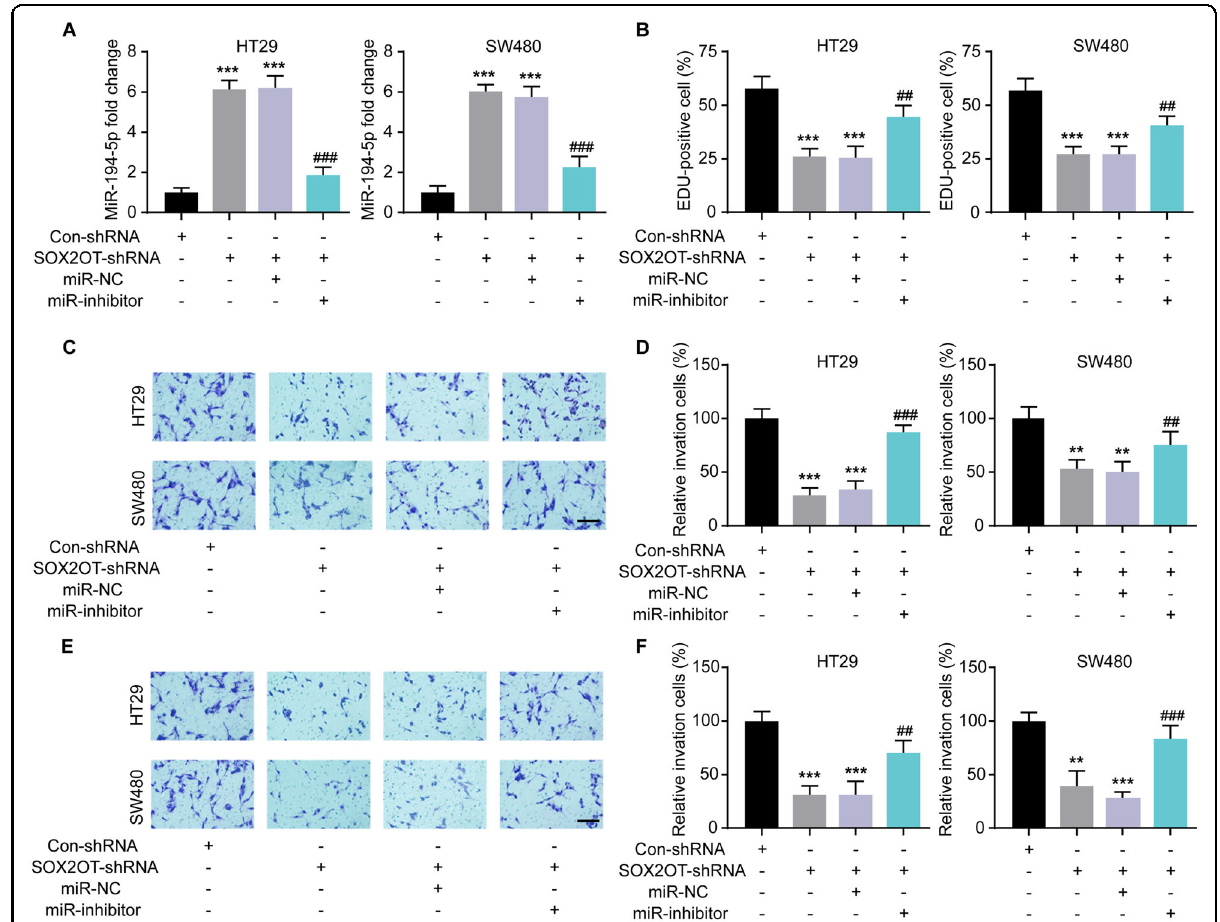
Fig. 5 Down-regulation of miR-194-5p counteracted the tumor suppressive effects of sh-SOX2OT in CRC cells. A qRT-PCR was used to detect the expression of miR-194-5p in CRC cells after transfecting with SOX2OT-shRNA and/or miR-194-5p-inhibitor (miR-inhibitor); functional rescue experiments were carried out in HT29 and SW480 cells including EDU assay ( B ), transwell migration assay ( C ), ( D ), transwell invasion assay ( E ), ( F ). ** P < 0.01, *** P < 0.001 vs. Con-shRNA; ## P < 0.01, ### P < 0.001 vs. SOX2OT-shRNA + miR-NC. Scale bar = 50 μ m. Data were expressed as mean ± SD. All experiments were repeated three